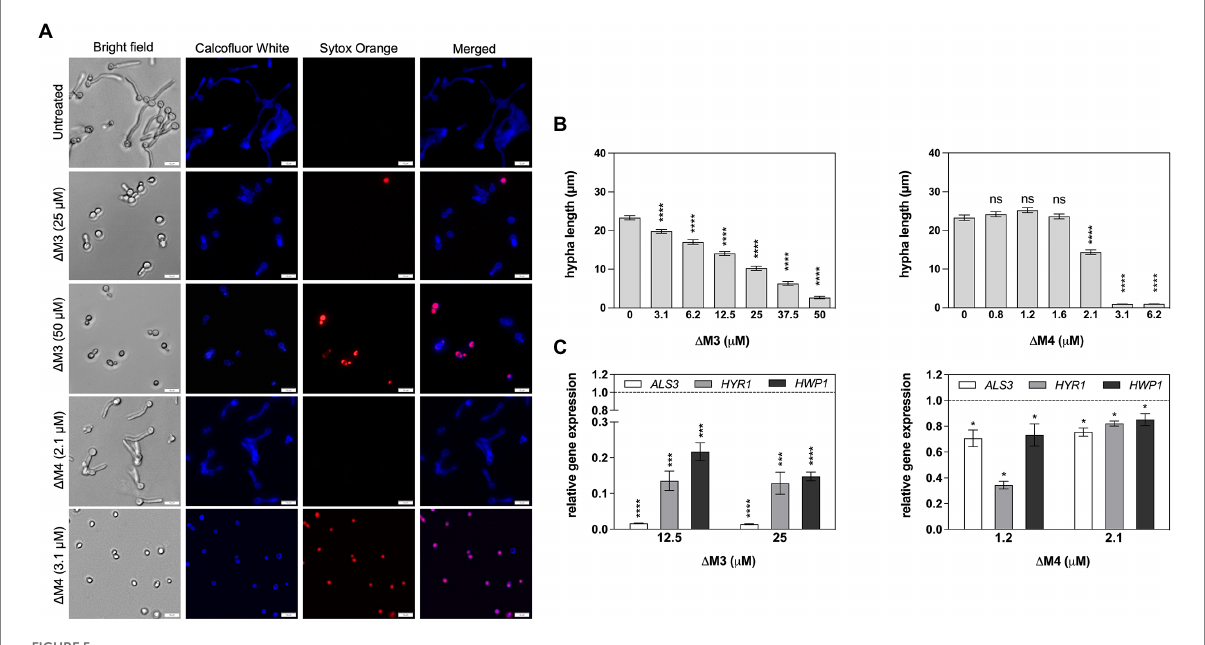
FIGURE 5 Impact of Δ M3 and Δ M4 on the transition of C. albicans from yeast to filamentous form. (A) C. albicans (10 5 /100 μ l) were incubated in RPMI 1640 medium with peptides at concentrations in the range of 3.1–50 μ M ( Δ M3) or 0.8–6.2 μ M ( Δ M4) for 90 min at 37 ° C. The fungi were stained with Calcofluor White (1 μ g/ml) or Sytox Orange (1 μ M) and visualized using Olympus IX73 microscope. (B) The length of the hyphae ( n = 20) was measured using Olympus CellSens programming. For statistical analysis one-way ANOVA with Dunnett’s multiple comparisons post hoc test was used (**** p < 0.001). (C) The mRNA expression of ALS3 , HYR1 and HWP1 was determined after contact of C. albicans cells (2 × 10 6 /ml) with Δ M3 (12.5 μ M and 25 μ M) and with Δ M4 (1 μ M and 2 μ M) for 90 min at 37 ° C. Bars represent the mean value ± SD from at least three independent experiments. A paired Student’s t test was used for statistical analysis. * p < 0.05, *** p < 0.005 and **** p < 0.0001 vs. untreated cells (dashed